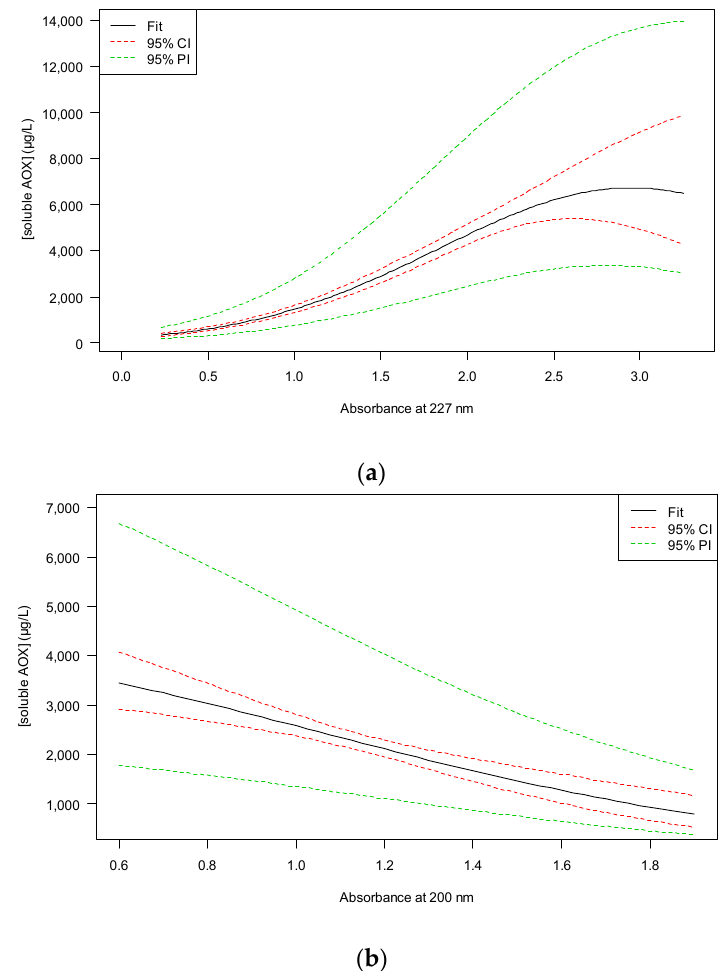
Figure 9. Confidence (CI) and prediction intervals (PI) for each individual predictor variable for the model predicting the soluble AOX concentration: ( a ) absorbance at 200 nm and ( b ) absorbance at 200 nm.